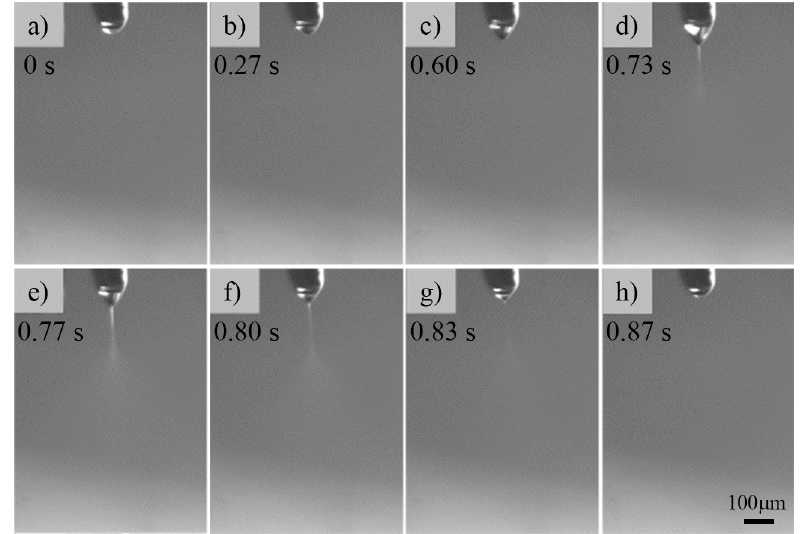
Figure 2. Discontinuous pulsed ejection of 4 wt% ZnAc aqueous solutions using a steel nozzle with an inner diameter of 60 μ m and an outer diameter of 110 μ m. ( a – c ) Solution pendant deformed by the applied voltage. ( d , e ) Liquid ejects from the nozzle. ( f – h ) The jet withdraws to the nozzle to form a hemispherical pendant. The nozzle-to-substrate distance was 2 mm, the applied voltage was 3 kV, and the flow rate of solution was 50 μ L/h.